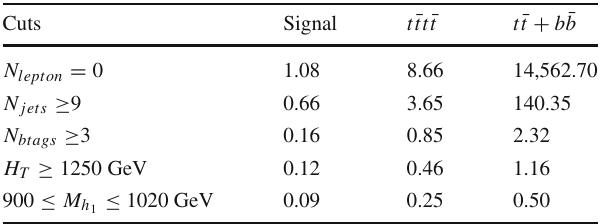
Table 2 Cut flow table for hadronic decay of all top quarks for the = 1 TeV M h 1